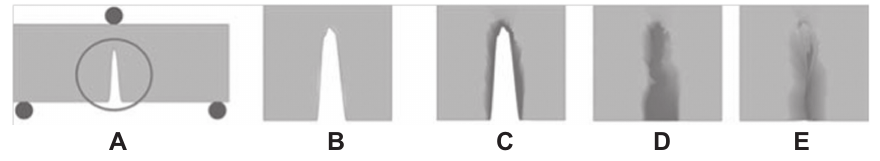
Figure 1 Basic mechanism of self-healing process. (A) Crack induction by mechanical load, (b) crack in detailed view, (C) induction of a “mobile phase”, (D) closure of the crack by the B “mobile phase”, and (E) immobilization of the “mobile phase” after healing (reprinted with permission from [3]). Copyright 2010, John Wiley and